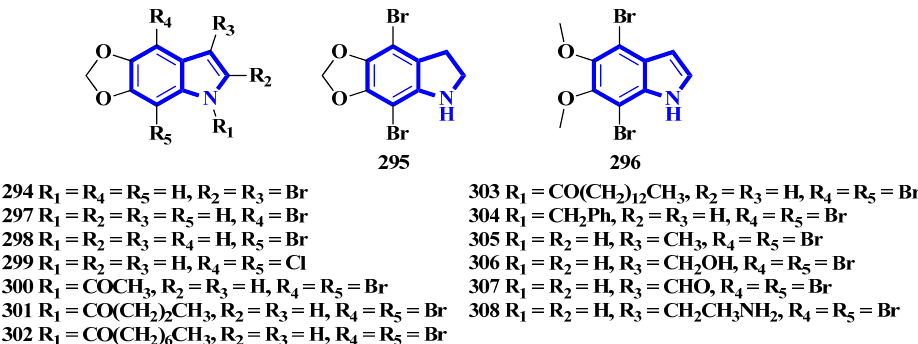
Figure 19. Amakusamine derivatives synthesized 294–308 .